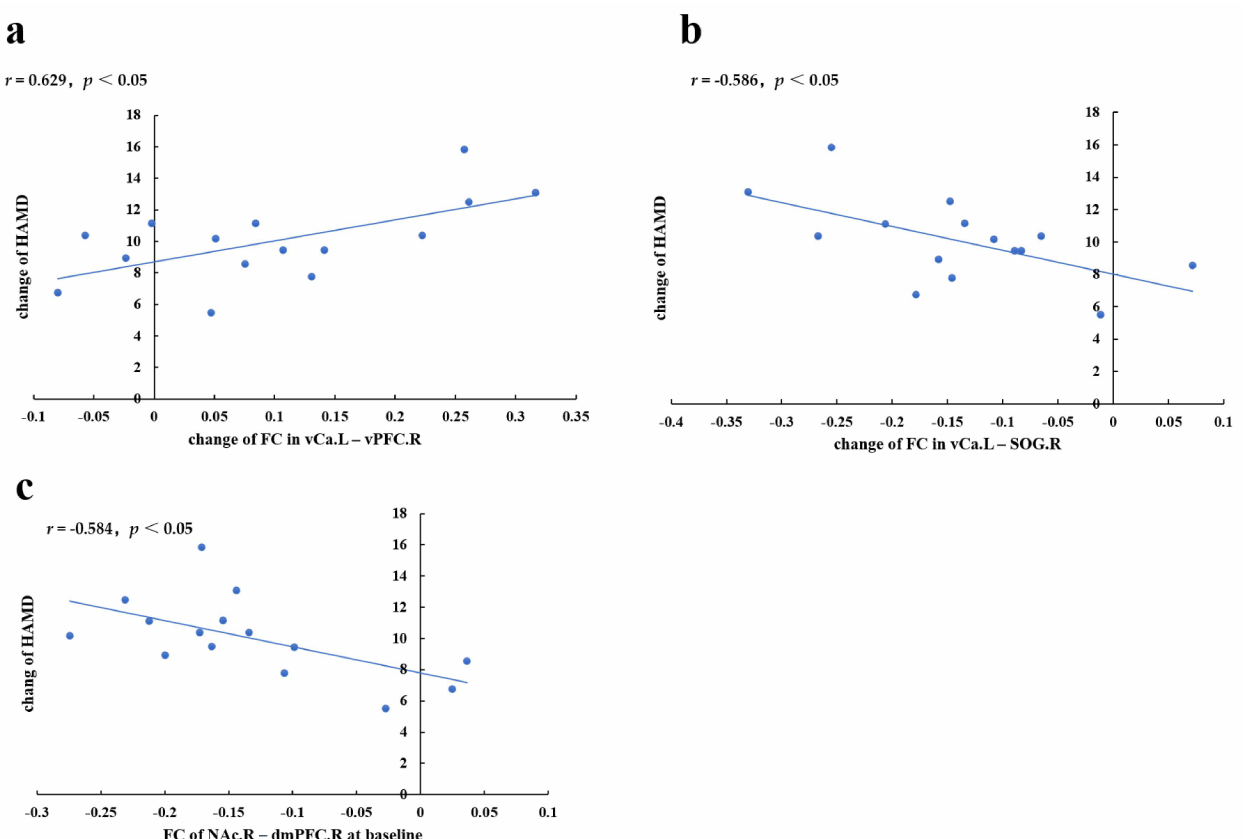
Figure 3. The correlation between the rsFC value and HAMD score. ( a , b ) The scatterplot map indicates a correlation between the change in rsFC in the left vCa–right vPFC, left vCa–right SOG, and the remission of the HAMD score. ( c ) The scatterplot map indicates a correlation between rsFC at baseline in R_NAc–R_dmPFC with the remission of HAMD. L, left; R, right. vCa, ventral caudate; vPFC, ventral prefrontal cortex; SOG, superior occipital gyrus; NAc, nucleus accumbens; dmPFC, dorsal medial prefrontal